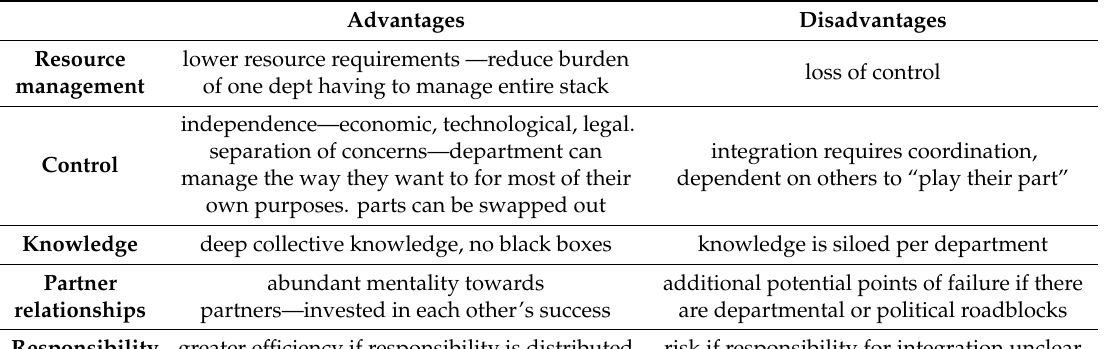
Table 2. Advantages and Disadvantages to vertical